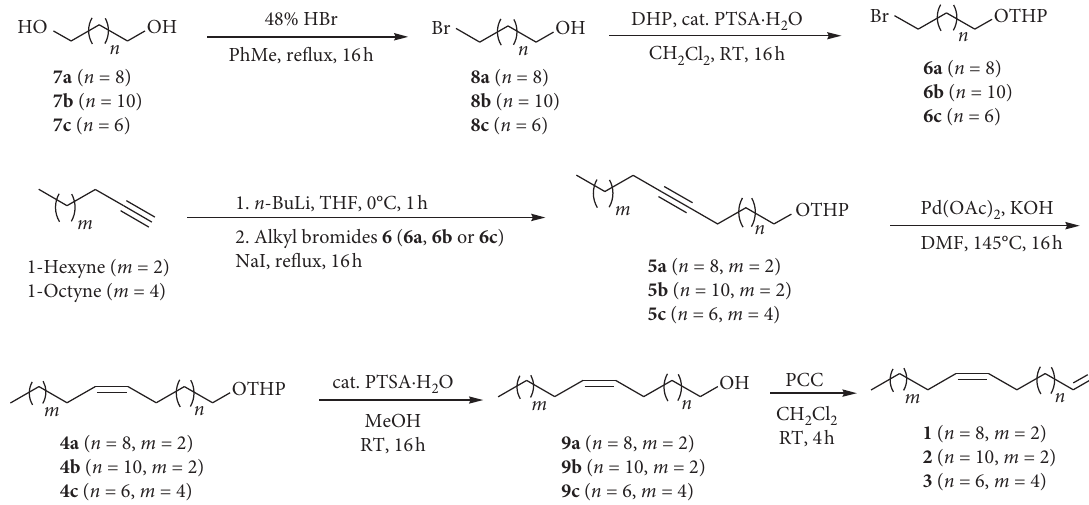
Scheme 2: Efficient synthesis of sex pheromone components 1 , 2 , and 3